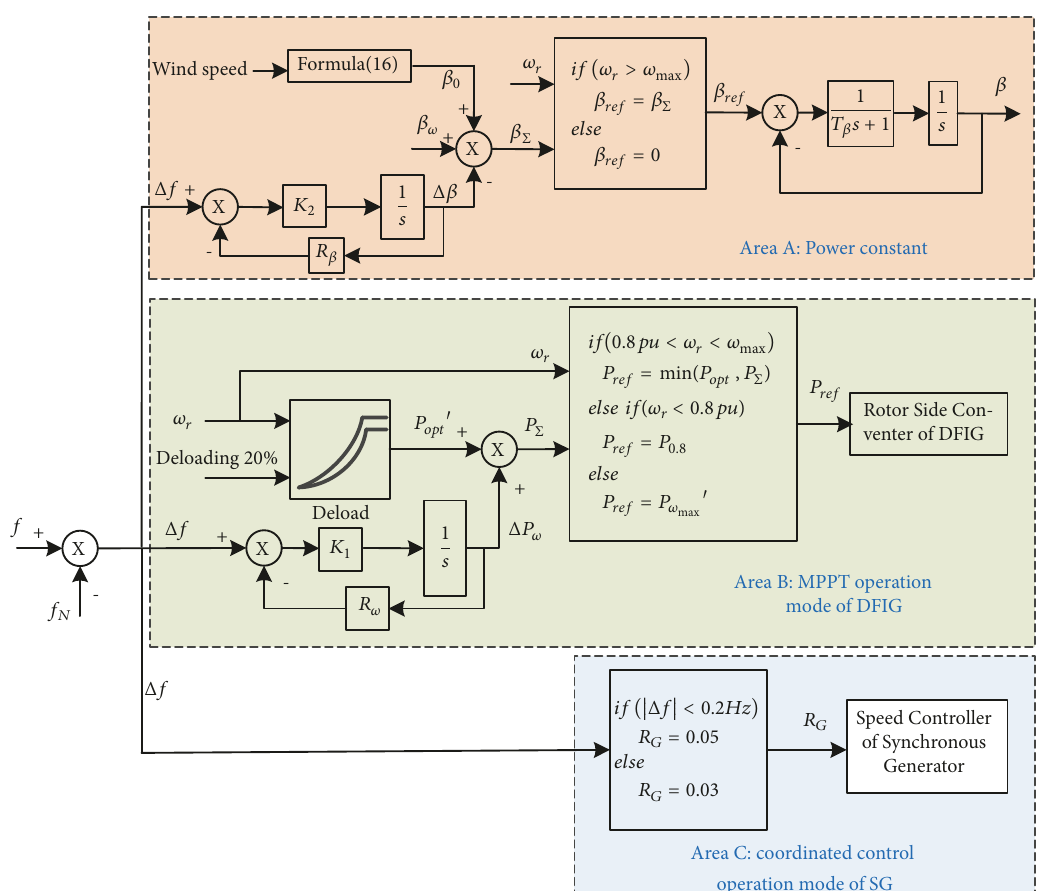
Figure 3: Primary coordinated frequency regulation structure of DFIG and synchronous